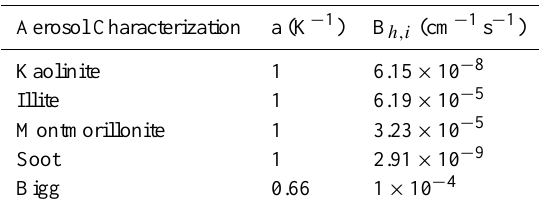
Table 1. Values for the freezing calculation constants (particle val- ues from Diehl and Wurzler,